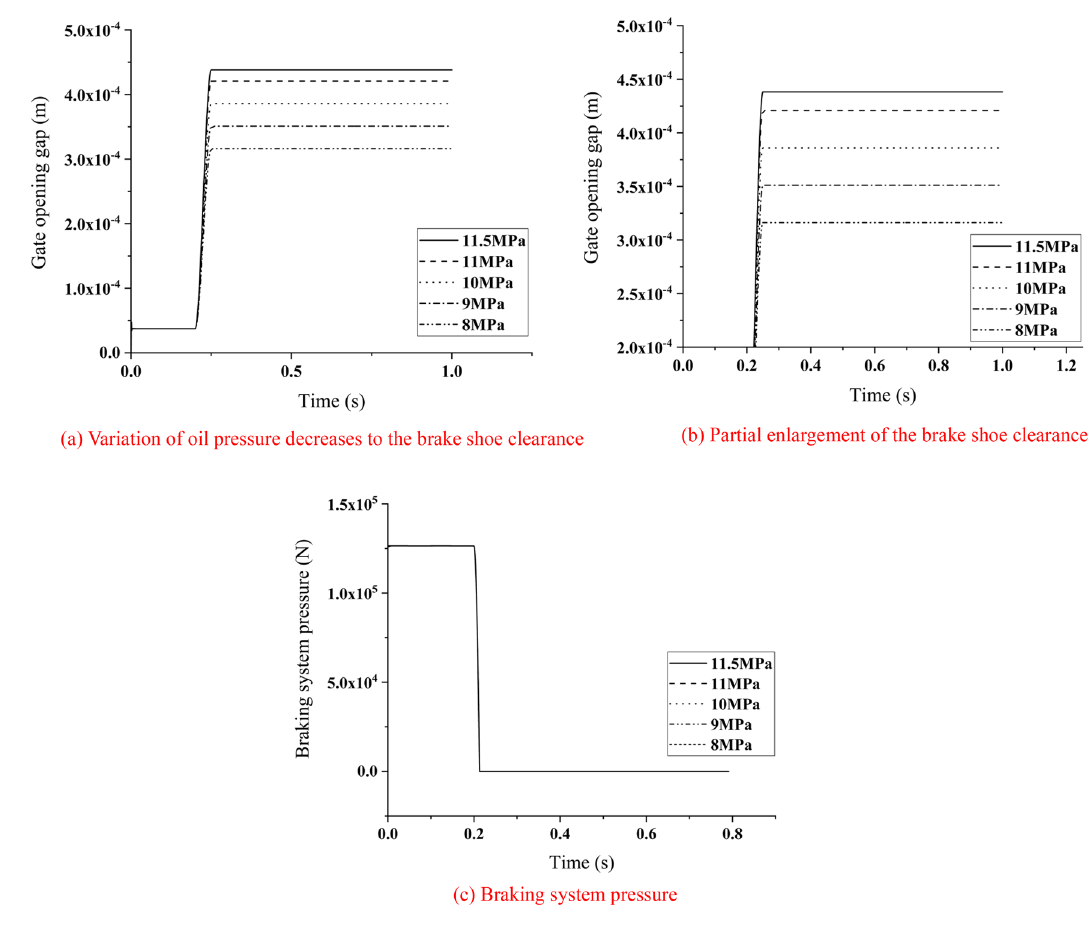
Figure 12. Variation of braking system parameters with reduction of oil